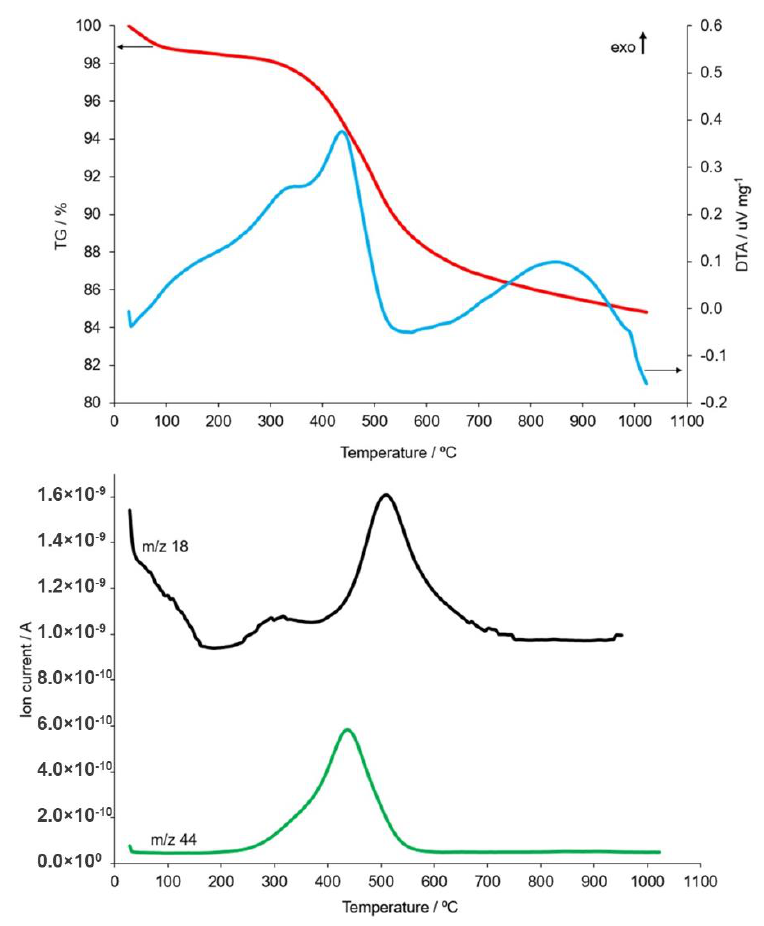
Figure 1. TG, DTA and MS curves (changes in content: H 2 O— m/z 18 and CO 2 — m/z 44) recorded during heating from ambient temperature up to 1000 °C of the R1 sample taken from the Piast hard coal mines.